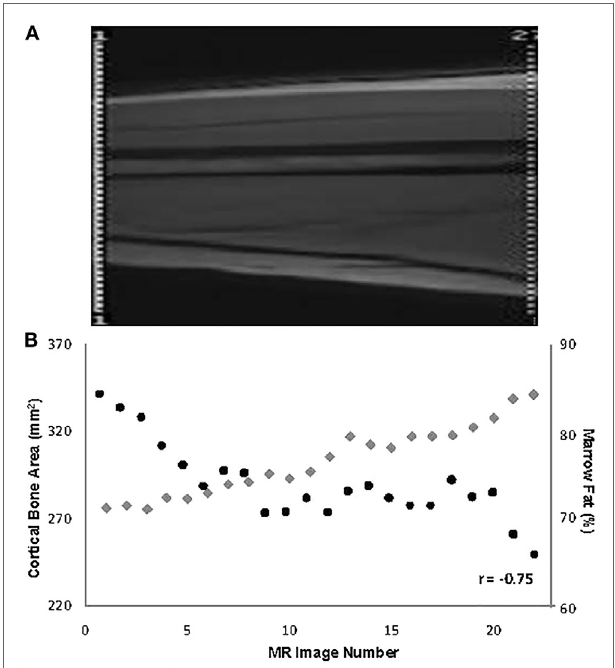
FiGURe 1 | (A) Depiction of the mid-third of the right femur in a 19-year-old male (the localizer image). (B) Values for % marrow fat (black circles) and cortical bone area (gray diamonds) at all slices along the mid-third of the right femoral shaft and their overall relationship in the same subject [reproduced from Wren et al.